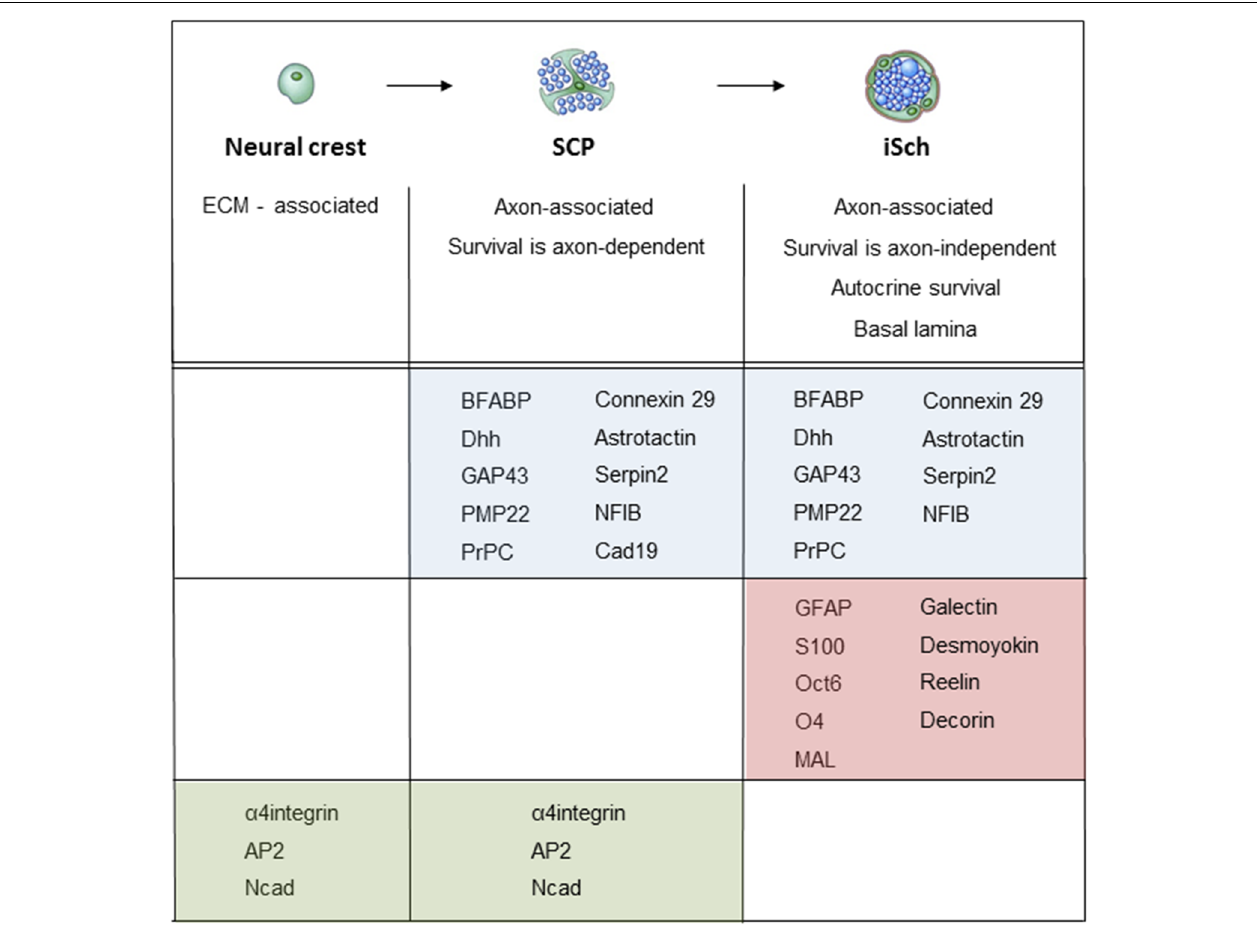
FIGURE 5 | Molecular expression at the main stages of the embryonic Schwann cell lineage. Below the lineage drawing, main cell biological differences between each developmental each stage are indicated. The molecular markers of each stage divide into three groups: (i) markers that are upregulated at the crest/SCP transition, and maintained by iSCh (blue); (ii) markers that are upregulated at the SCP/iSch transition (pink); and (iii) markers that present on neural crest cells and SCP but are downregulated at the SCP/iSch transition (green). For references, see Jessen and Mirsky (2005a) where more detailed comments on gene expression patterns are